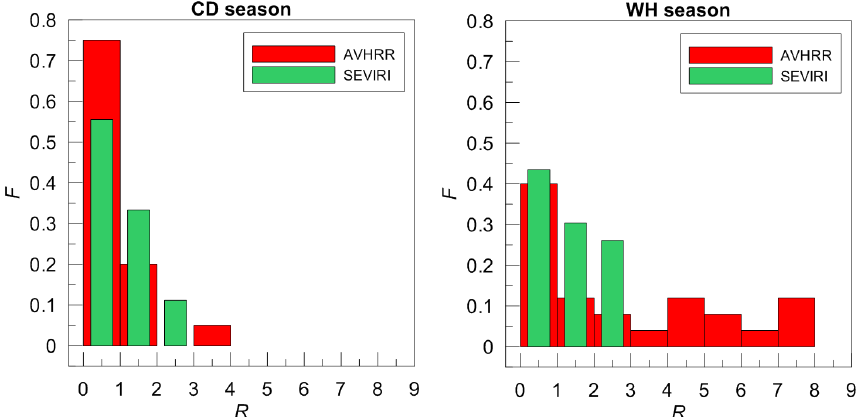
Figure 7. The relative frequency of occurrence ( F ) of the ratio ( R ) of the absolute difference between the satellite and ground-based data to the LWP uncertainty reported by the satellite instruments (cloudy conditions